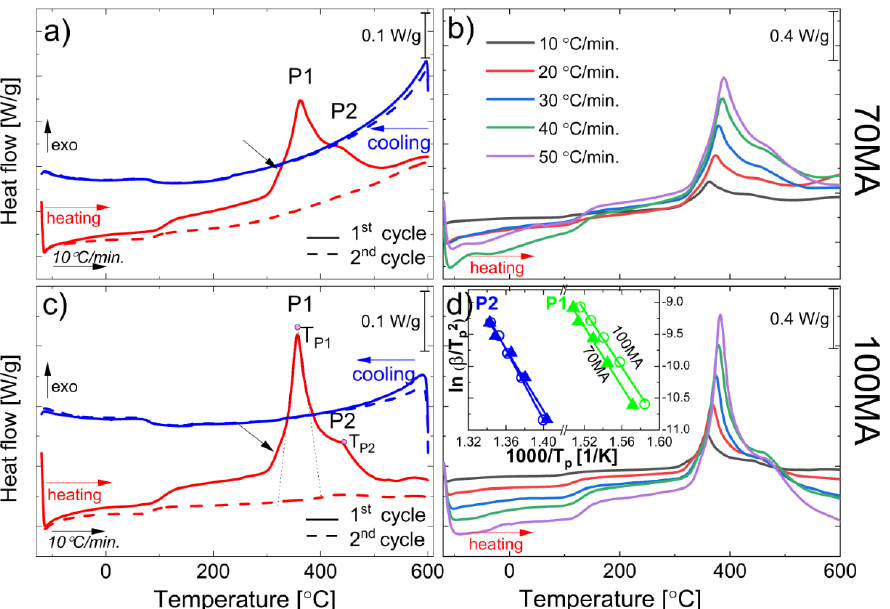
Figure 4. DSC curves collected for samples ( a ) 70MA and ( c ) 100MA during the 1st and 2nd cycles of cooling/heating with 10 °C/min. Peak temperature (T p ) determined as the intersection of tangents to the peak ʹ s slopes (dotted lines). Non ‐ isothermal DSC curves, 1st cycle, heating rates between 105 °C/min and 50 °C/min) for: ( b ) 70MA, and ( d ) 100MA powders, inset: ln ( β /T p2 ) vs. 1000/T p of P1 and P2 peak for 70MA (triangles) and 100MA (circles) powders. Black arrows mark “bumps” in the DSC curve, referring to the crystallization of the amorphous phase.